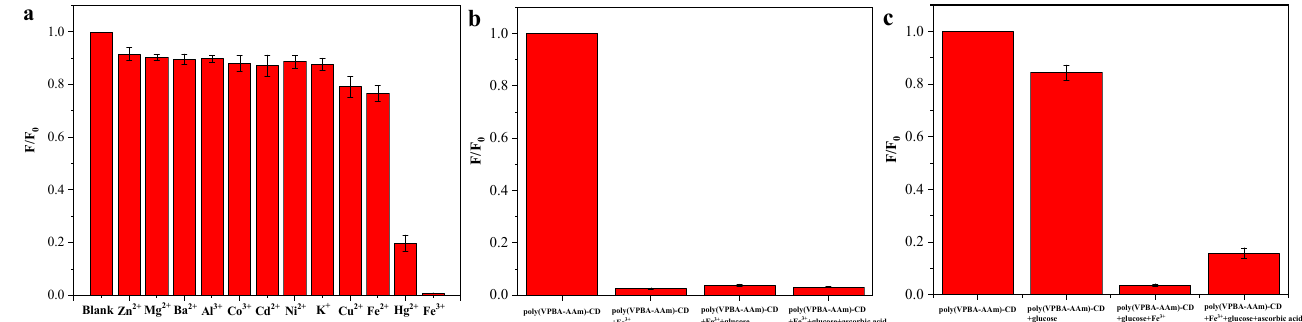
Figure 9. Influence of metal ions ( a ), Fe 3+ ( b ) and glucose ( c ) addition in that order on the fluorescence intensity of poly(VPBA-AAm)-CD. Cpoly(VPBA-AAm)-CD = 0.26 mg/mL in pH 7.4 PBS, Cmetal ions = 3.0 mM, Cglucose = 10 mM, Cascorbic acid = 7.0 mM, λ em = 375 nm, λ ex = 310 nm.